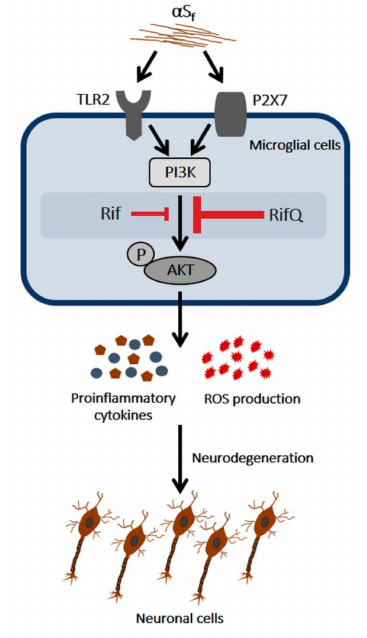
Figure 8. Simplified scheme describing how Rif and RifQ attenuate the inflammatory response of microglial cells exposed to α S f . Microglial TLR2 and P2X7 receptors recognize fibrils of α S, which results in AKT phosphorylation by PI3K. This leads to stimulation of cytokine release and to a burst of oxidative stress, presumably by activation of the reduced nicotinamide adenine dinucleotide phosphate oxidase enzyme. Both pro-inflammatory cytokines and ROS are potentially deleterious for neuronal cells. The suppressive e ff ect of Rif and RifQ on cytokine release is probably due to inhibition of both PI3K and non-PI3K-dependent signaling events. The control of oxidative stress appears, however, essentially dependent on PI3K inhibition. The inhibitory e ff ects that Rif and RifQ exert on activated microglia may provide indirect protection to neuronal cells. RifQ appears constantly more e ff ective than Rif in reducing inflammatory-type reactions and in providing neuronal